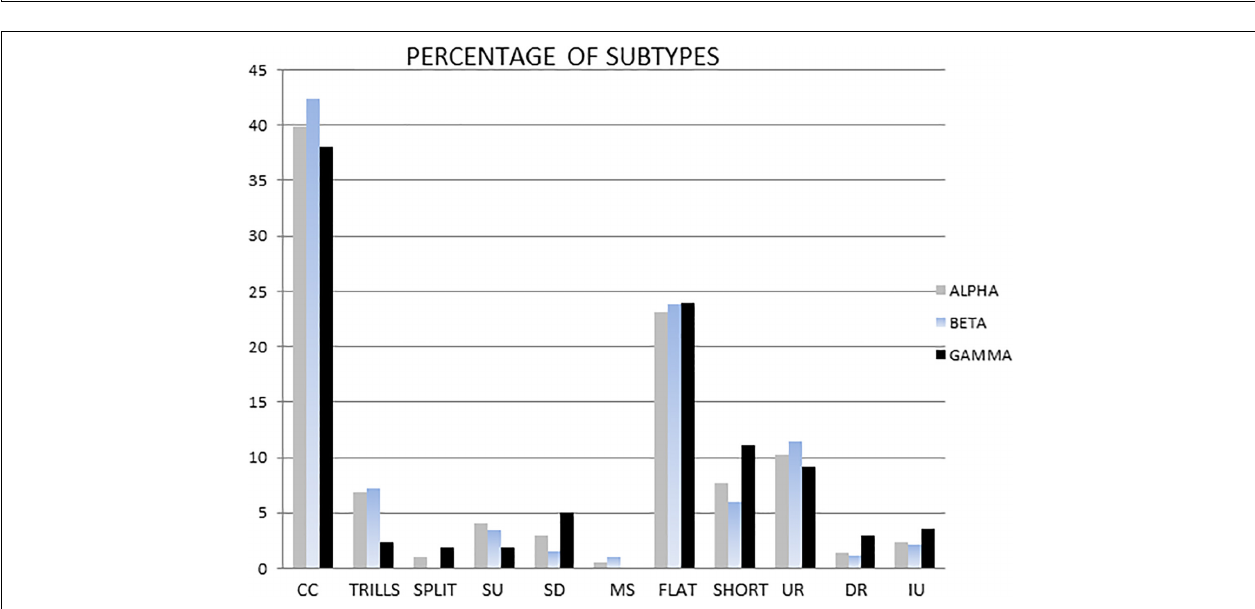
FIGURE 4 | The means number (SE) of PVs emitted by alpha, beta, and gamma groups. 1—Alpha group, 2—Beta group, and 3—Gamma group. ∗ Statistically significant differences ( P < 0.05) compared with the alpha group.